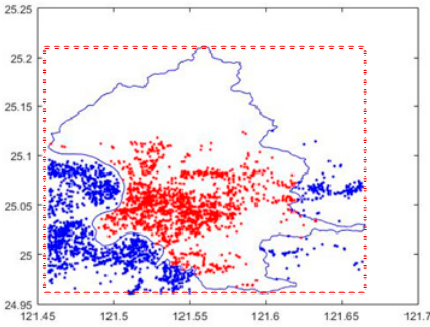
Figure 5. Point distribution of subarea 1 and its neighborhood. The range is longitude 121.45 to 121.67 and latitude 24.95 to 25.22. The number of points in this range is 93,549. Randomly, 1600 points inside subarea 1 and 1600 points not-inside subarea 1 are marked on this range.